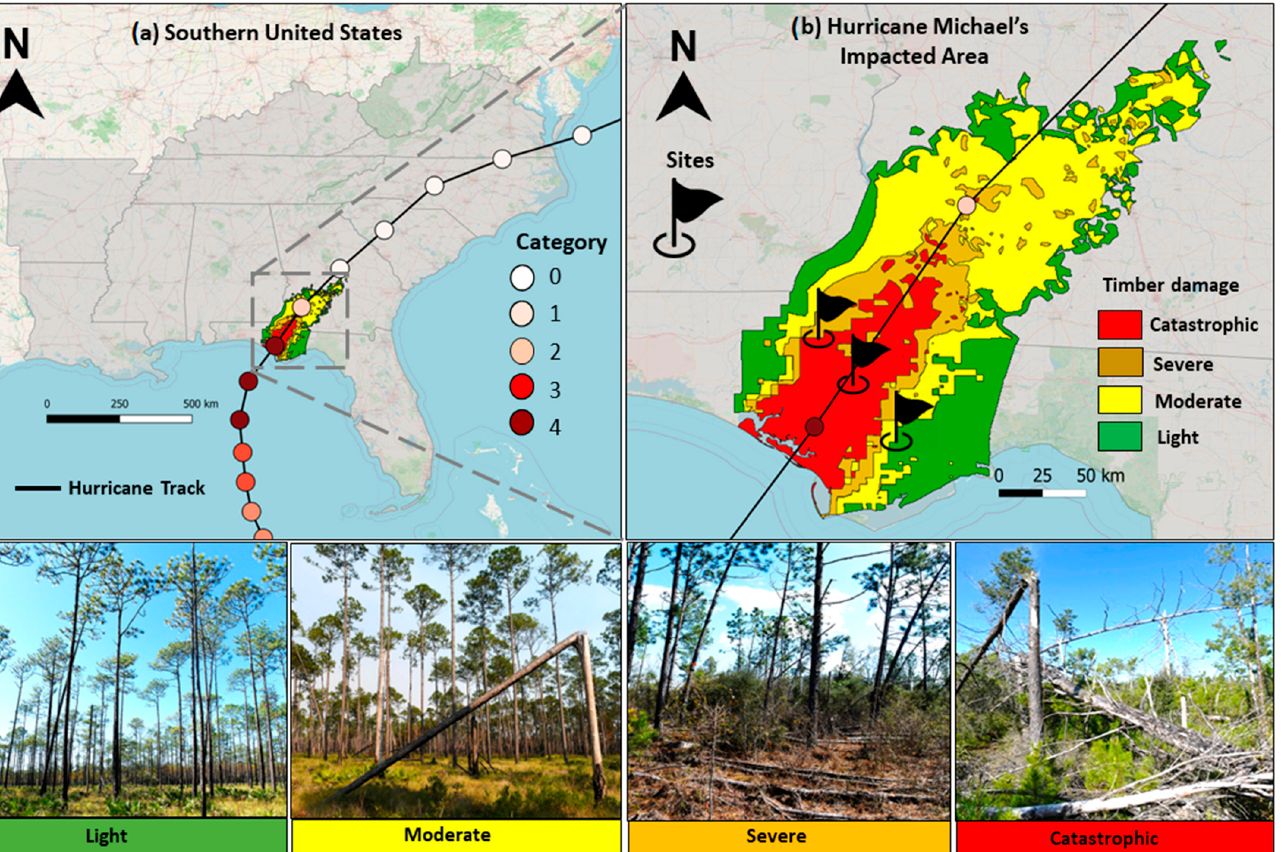
Figure 1. Hurricane Michael path and category in the Southern US and study sites located within the area impacted by Michael within the Apalachicola National Forest (ANF) and private forests areas ( a ). Area impacted by Hurricane Michael (36,218.00 km 2 ) and study sites location ( b ). The timber damage severity map was produced by the Georgia Forestry Commission and Florida Forest Service